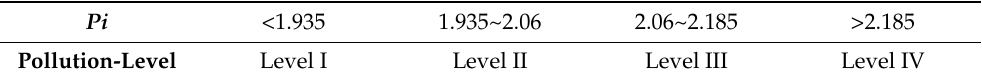
Table 5. Divisions criteria of blasting pollution-levels with the homologous pollution